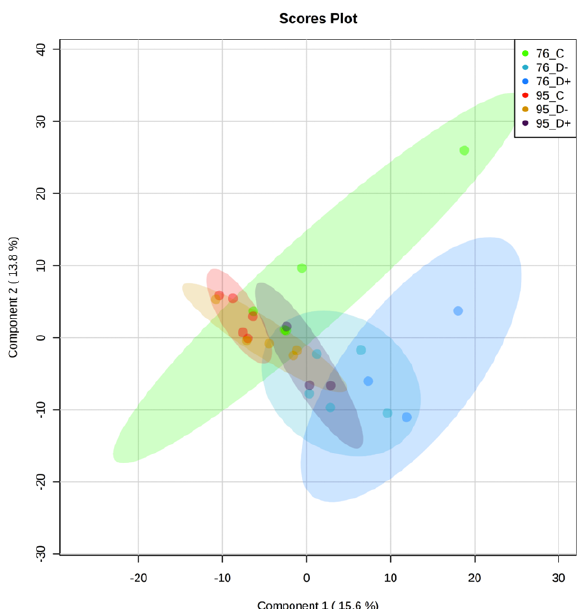
Figure 2. Partial Least Square (PLS) analysis of metabolite data obtained from GC-MS analyses of grapevine leaf extracts from different grapevine leaf samples of Chardonnay clones 76 and 95. For each group, individual samples are displayed as symbols and concentration ellipses are included. (C): green leaves sampled on heathy vines, as controls; (D-): green leaves sampled on asympto- matic canes of esca-affected vines showing partial apoplexy symp- toms; (D+): green leaves sampled on symptomatic canes of esca- affected vines showing partial apoplexy